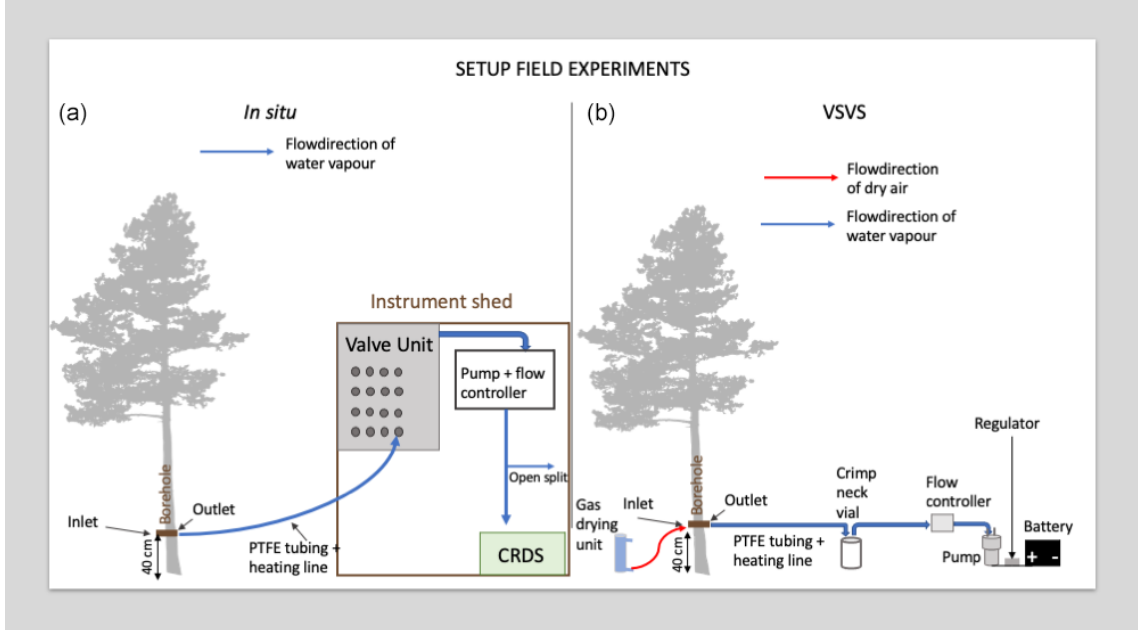
Figure 3. Comparison of in situ field setup (a) and sampling setup to obtain VSVS samples (b)